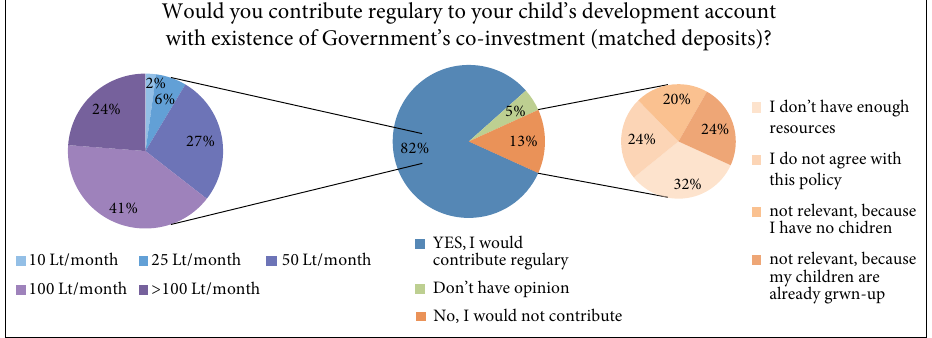
Fig. 12. Respondents’ opinion towards personal contributions to the CDA with existence of Government’s co-investment (authorial computation, according to the survey